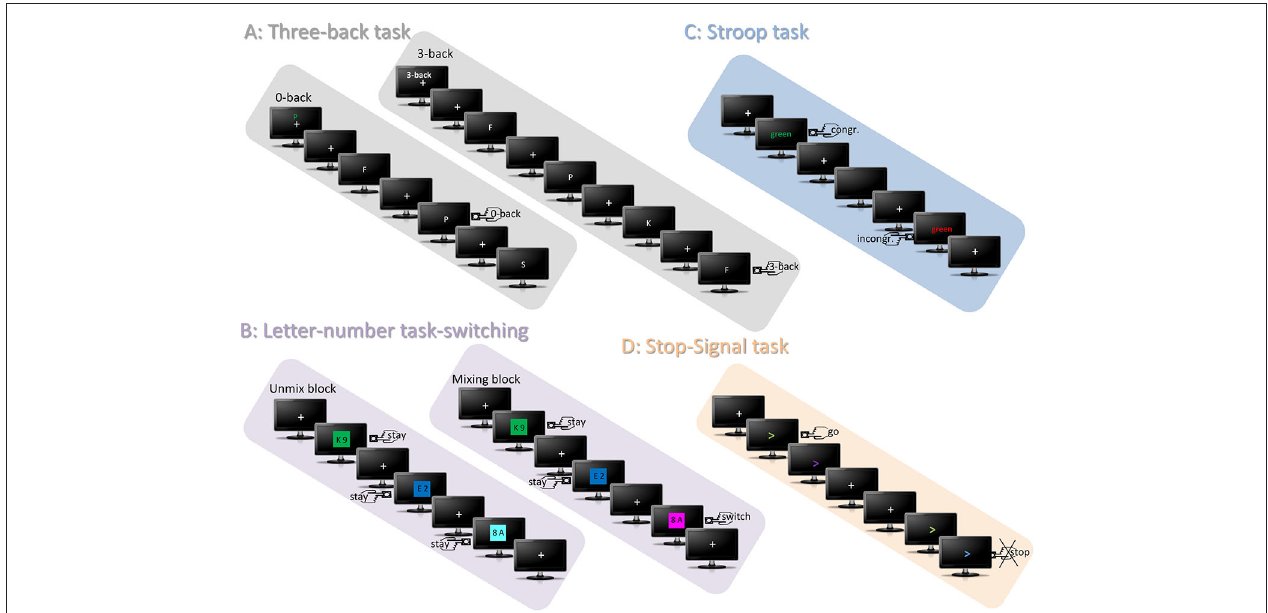
also introduced and indicate that categorization has to be performed concerning both letters and numbers, each respectively. Thus, the third trial of the depicted example “mixing-block” requires a “switch” of number categorization to letter categorization and thereby leads to another required response, since vocals have to be responded with the right hand. (C) Represents the trials of the Stroop task requiring the categorization of the presentation color (e.g., right button press for presentation colors), but not the word-meaning. Consequently, although the word meaning in this example is the same, the required button-press is different because of the different presentation color of the word. (D) Shows exemplarily two trials of the visual stop-signal task, whereby the directions of the arrows are indicating the response side. In this example the color change into purple should be ignored, however, the change into blue indicates to stop the initiated